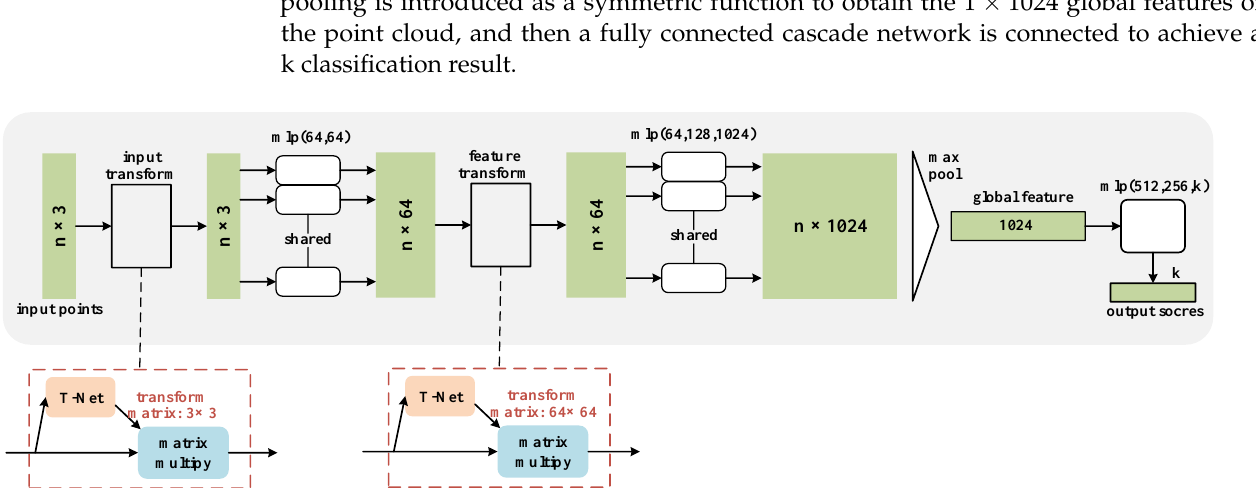
Figure 6. Overall structure of point cloud classification network. The dotted boxes are input point cloud T-Net network and feature transformation T-Net network respectively.